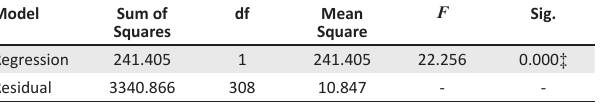
TABLE 2: ANOVA .† Model